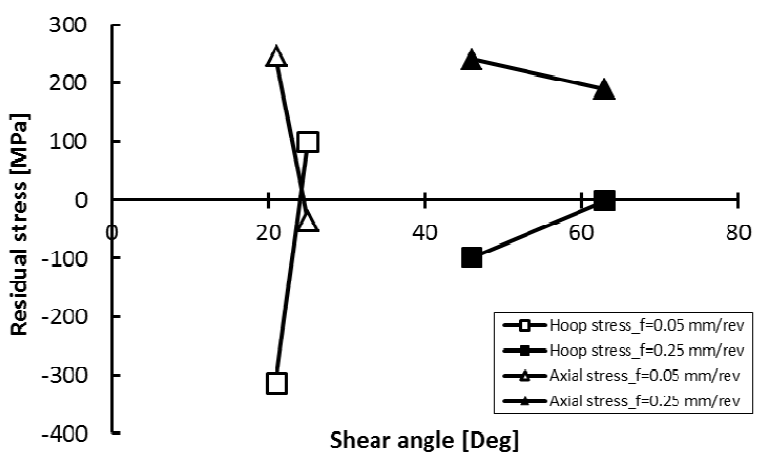
Figure 20. Effect of the shear angle on the surface residual stresses.